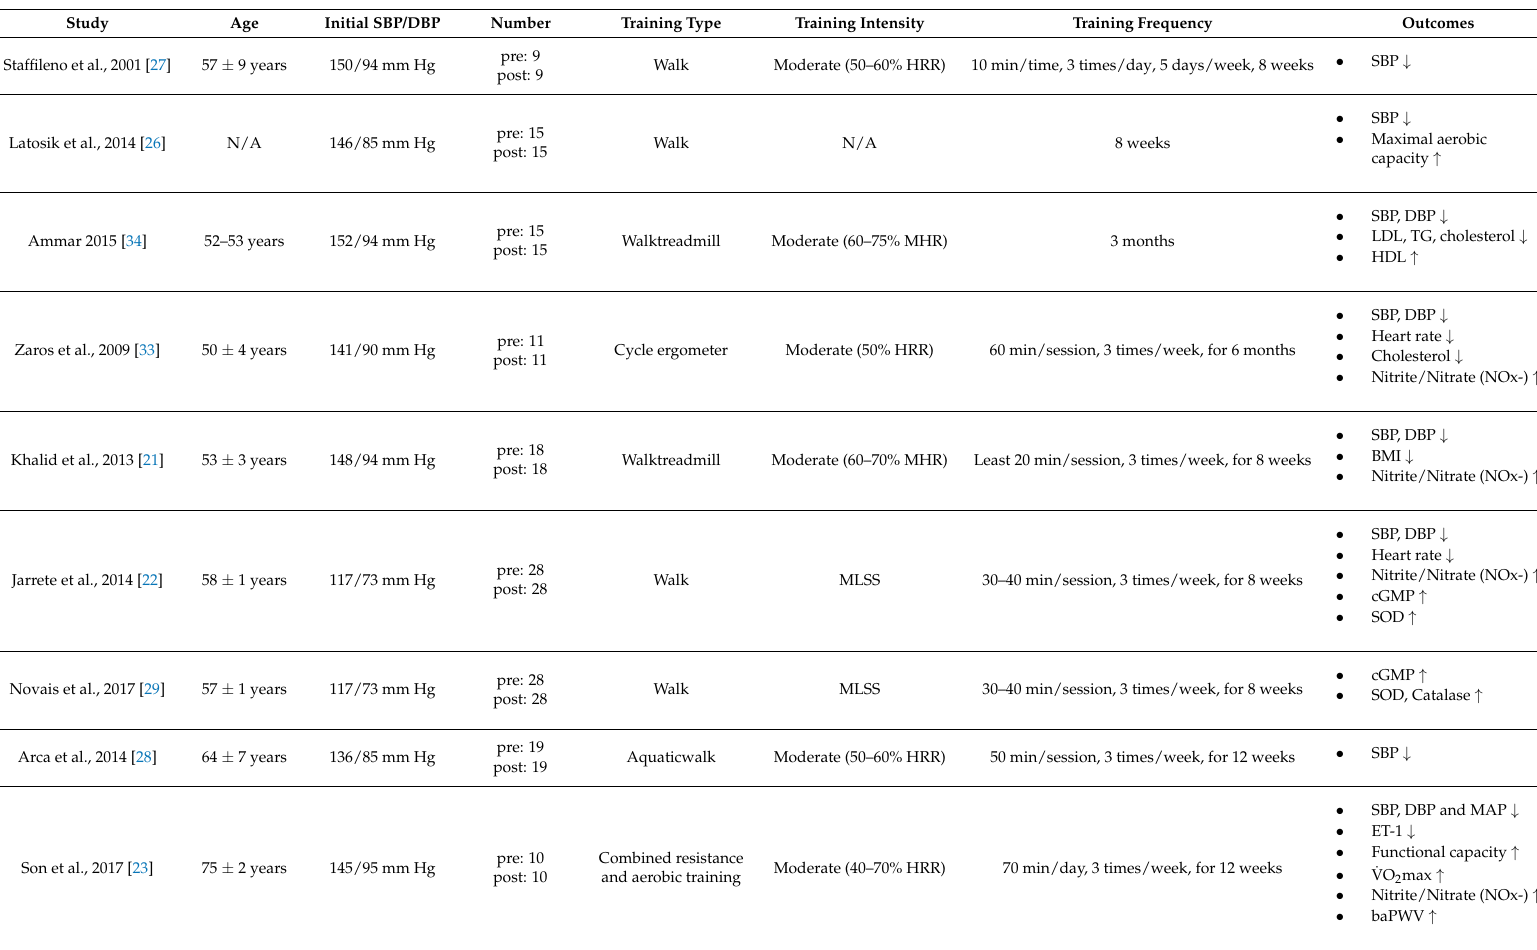
Table 1. Summary of exercise training protocols and outcomes from postmenopausal hypertensive